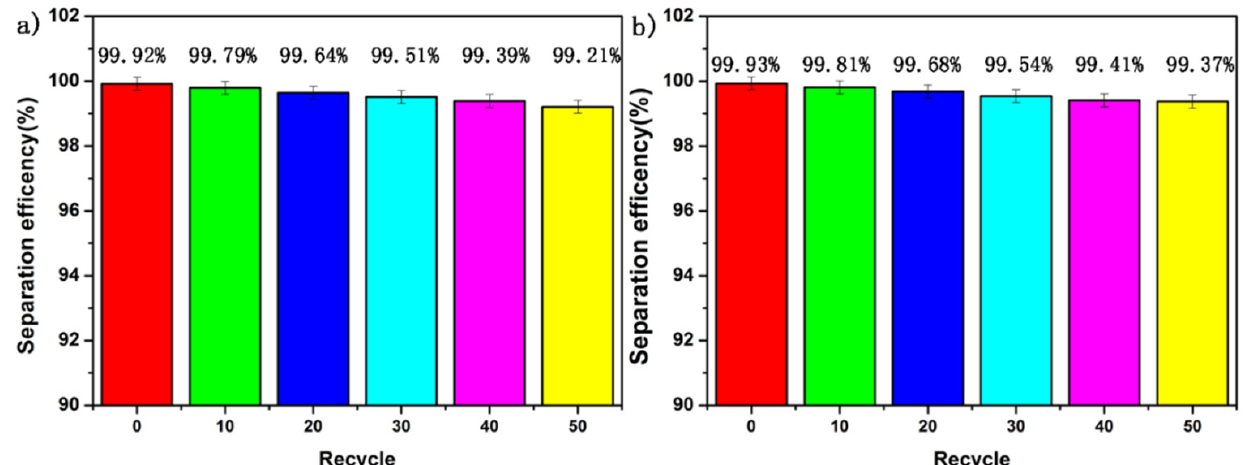
Figure 8. Variation of separation efficiency with times under salt ( a ) and acid ( b ) environments.